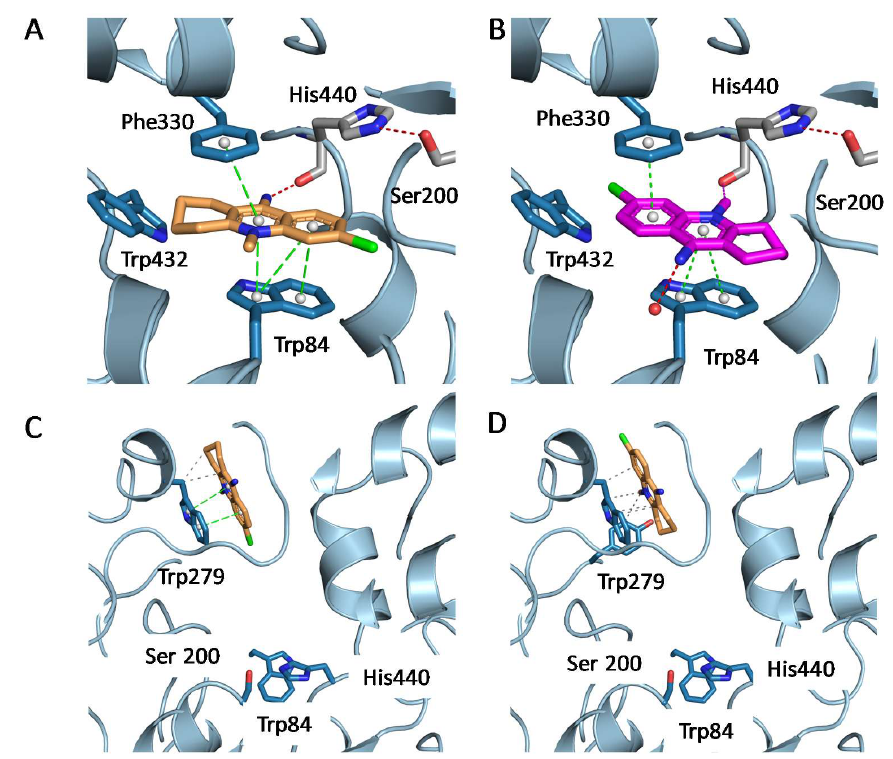
Figure 2. Binding mode of 5 within the Tc AChE active site ( A , B ), and at the PAS ( C , D ). In the active site, the major pose is represented in ( A ), with the conjugated system of 5 π-stacked between Phe330 and Trp84. However, the Cl atom does not point towards Trp432, as usually observed for 6- chlorotacrine derivatives, and the nitrogen of the exocyclic amino group is H-bonded to the carbonyl group of catalytic His440. A minor pose has also been modeled, with the Cl atom towards the hydrophobic pocket. In this orientation, the methyl group makes close contact (2.7 Å) with catalytic His440, and potentially interacts via a weak H-bond [45]. At the peripheral site, two orientations are also observed, and were refined with identical occupancies (0.5). Hydrophobic interactions are represented as dashed gray lines, π-stacking interactions are in green, and hydrogen bonds are in red.